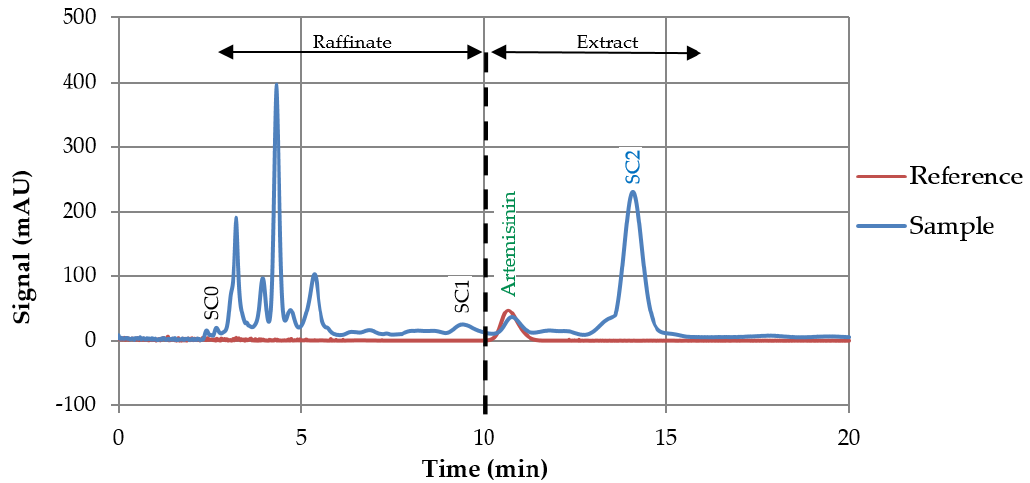
Figure 14. Binary split for the SMB separation and declaration of the key components.